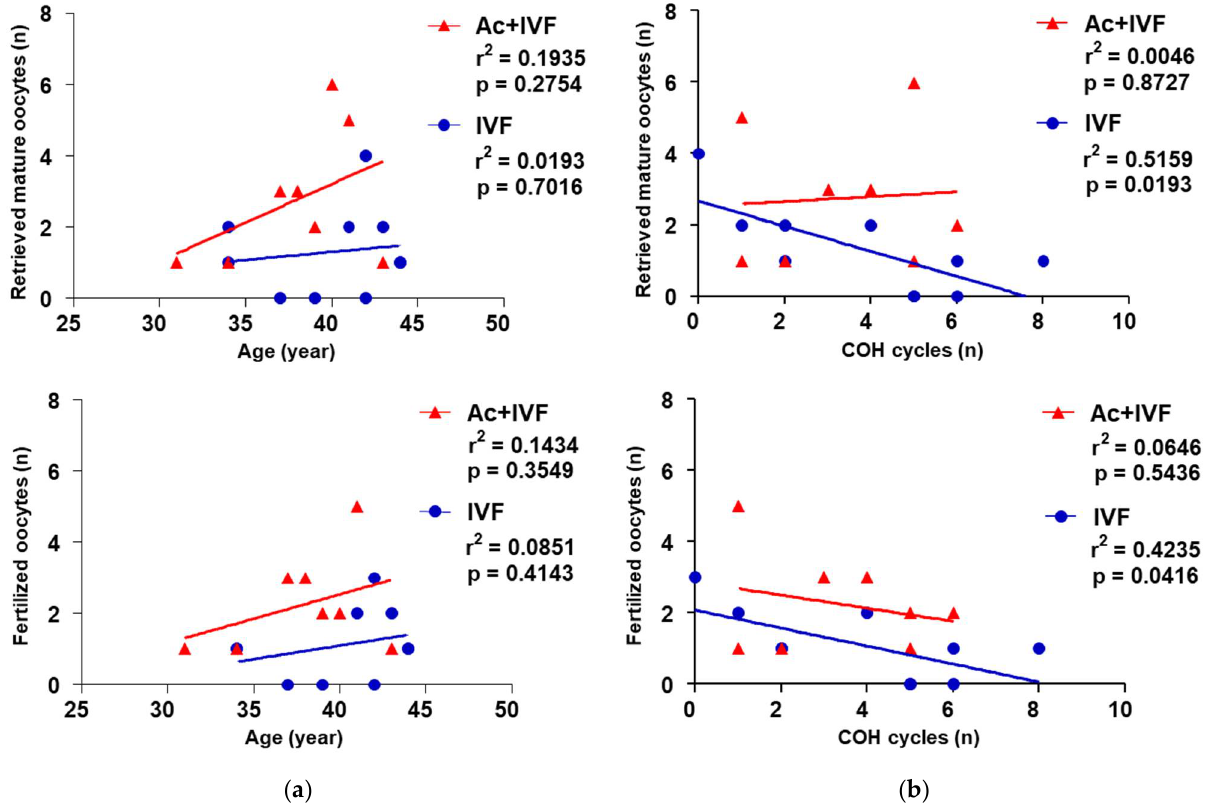
Figure 6. Comparison of correlation between clinical outcomes and the two characteristics in two study groups. Correlation of the number of retrieved mature oocytes and fertilized oocytes with the number of COH cycles ( a ) and age ( b ). Correlations are determined using multivariate linear regression analysis. IVF, in vitro fertilization; Ac + IVF, combination of acupuncture and IVF treatment; COH, controlled ovulation hyperstimulation.